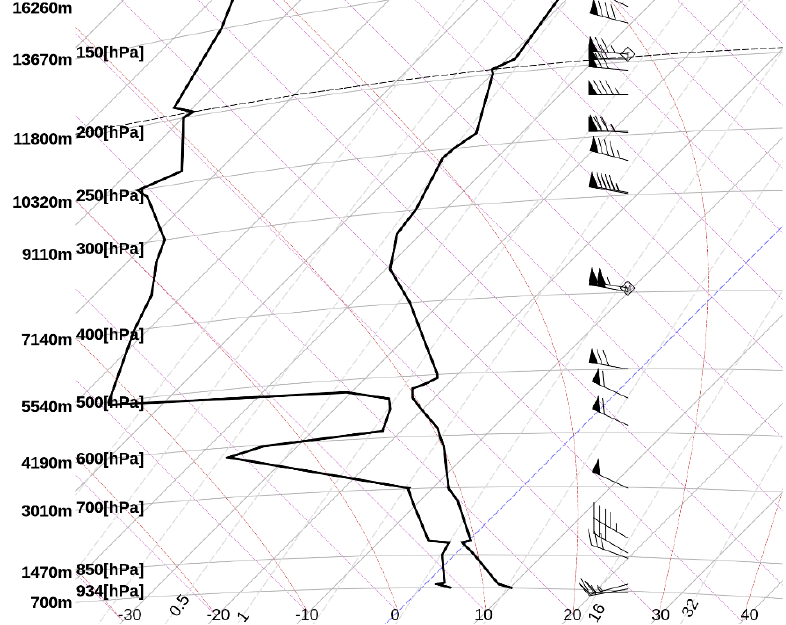
Figure 9. Gánovce sounding measured on 3 October 2018 12:00 UTC. Figure 9. G á novce sounding measured on 3 October 2018 12:00